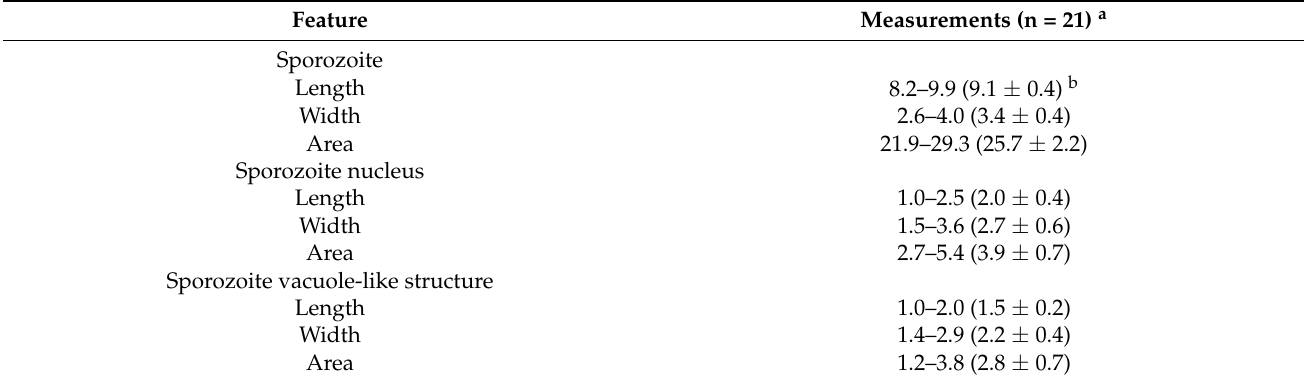
Table 2. Morphometry of sporozoites of Lankesterella bivacuolata n. sp. ( 18S rRNA lineage LanTurd1). All the measurements are given in